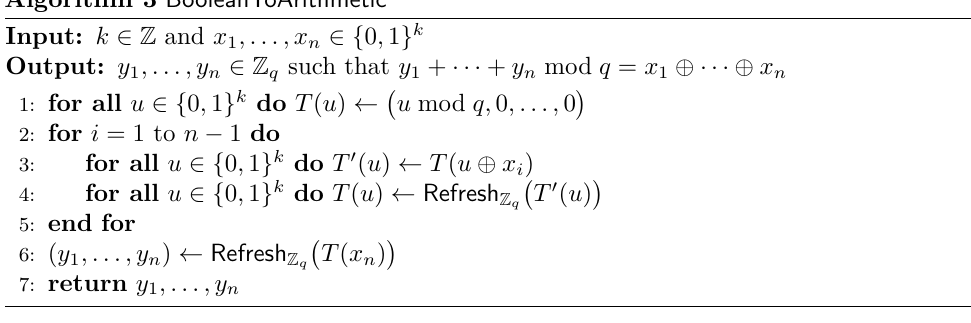
Algorithm 3 BooleanToArithmetic